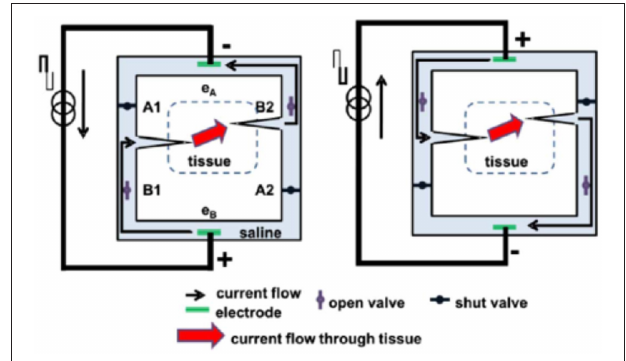
FIGURE 1 | Principle of SDCS operation. The two diagrams indicate two states of the same device. The device converts electronic current delivered between electrodes e A and e B to ionic current delivered to the tissue. When the pulse switches current direction, the valves switch states and the ionic current is driven through the alternate paths of the bridge. In both cases the ionic current is driven from left to right. Figures adapted with permission from Fridman and Della Santina